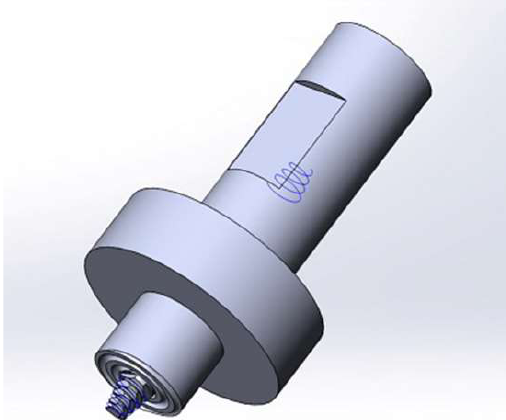
Figure 2. 3D model of the FSW tool.